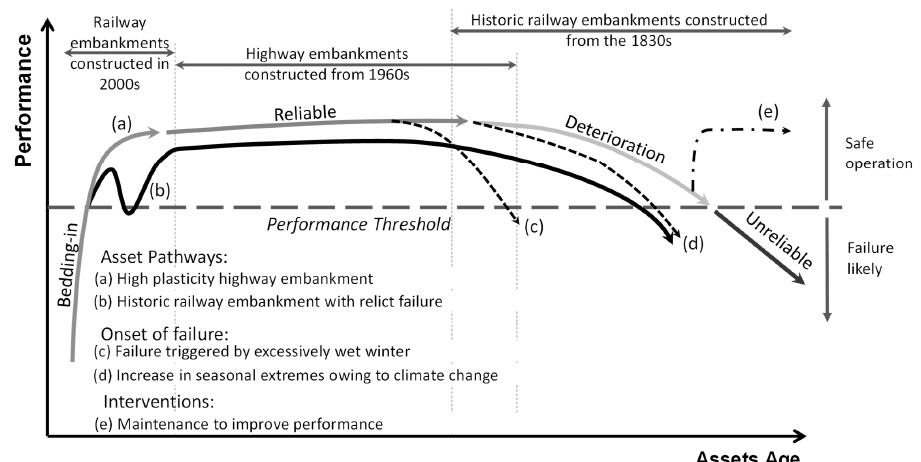
Figure 10. Deterioration curves showing the change in performance of an embankment over time, where curve ( a ) represents a high plasticity highway embankment; ( b ) historic railway embankment with relict failure; ( c ) failure triggered by an excessively wet winter; ( d ) increase in seasonal extremes owing to climate change; and ( e ) maintenance to improve performance (modified after Briggs, et al. [71]).